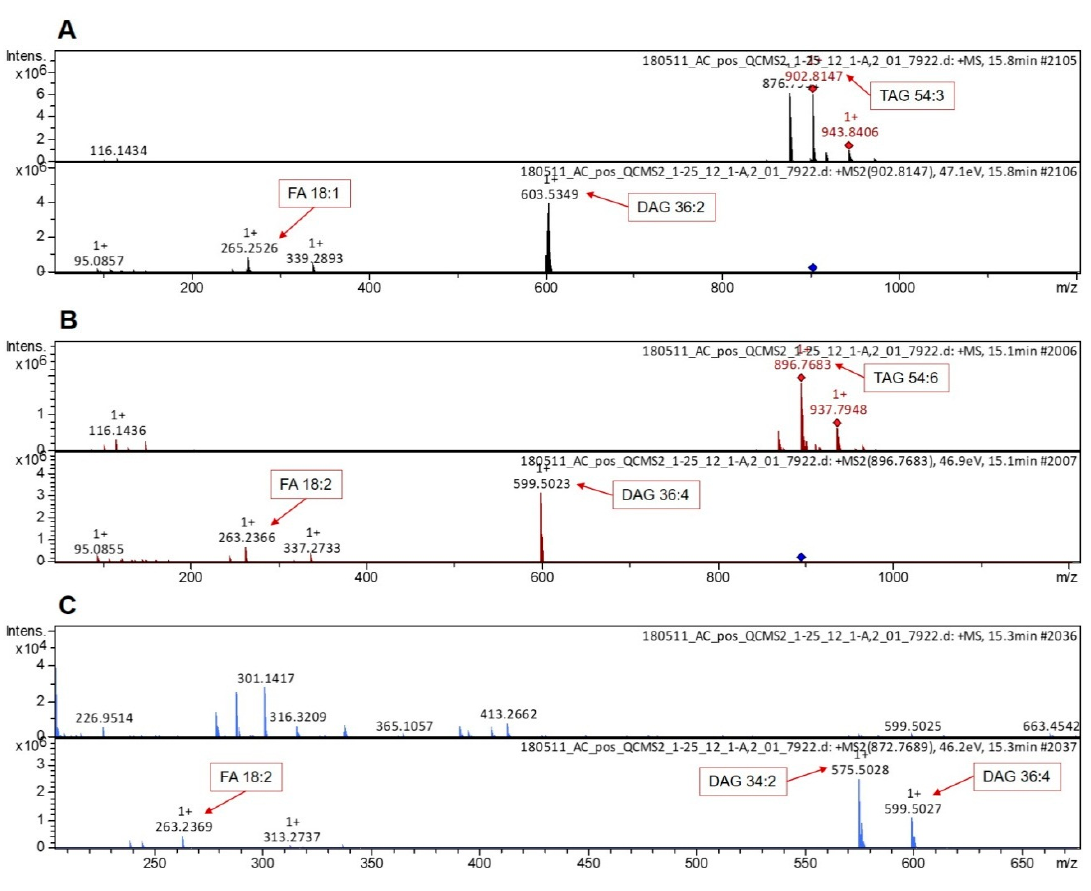
Figure 3. MS2 fragmentation spectra with fragment annotation. ( A ) Fragmentation spectrum for TAG 54:3. ( B ) Fragmentation spectrum for TAG 54:6. ( C ) Fragmentation spectrum for TAG 52:4. DAG: Diglycerides.